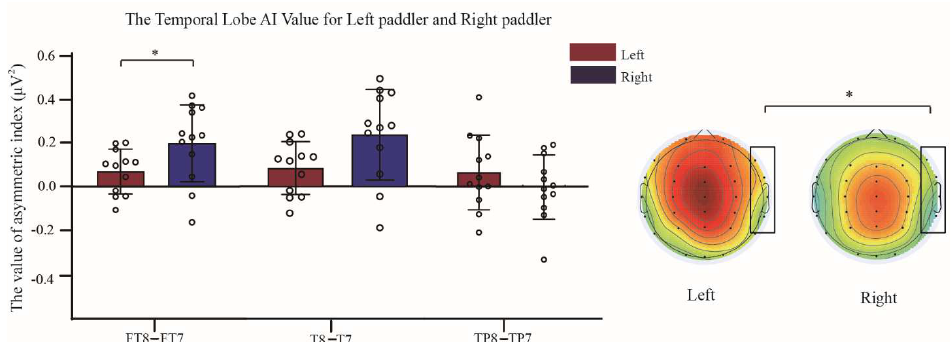
Figure 3. Brain area Asymmetric index (AI) in θ band between the two groups. The AI of the right − paddlers group is significantly greater than that of the left − paddlers group after rowing. The brain energy image displays the distinct in left paddlers and right paddlers (black box). Error bars represent the SD. Asterisks indicate significant differences between conditions (* p < 0.05). Left: left − paddlers group, Right: right − paddlers group.